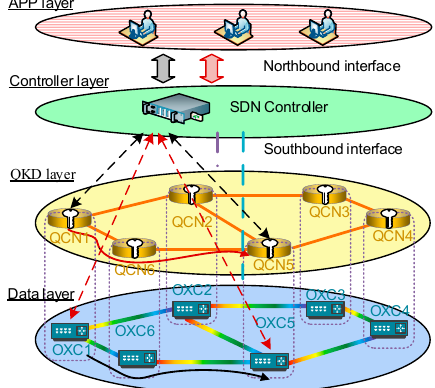
Figure 1. The architecture of optical networks secured by QKD [17].